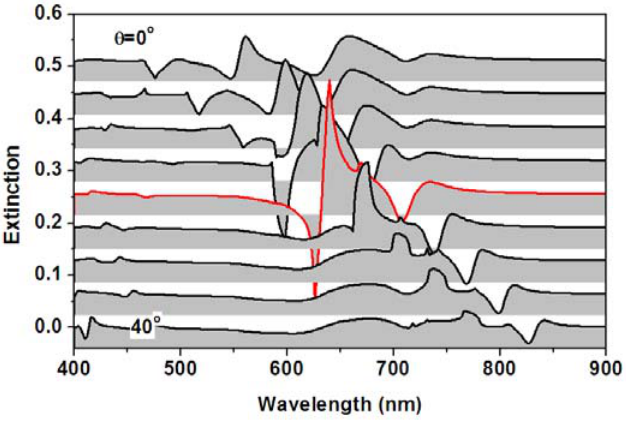
Figure 12. The extinction spectra at different angles of incidence (from 0 to 40 degrees in steps of 5 degrees) with the transmission spectra for n = 1.36 used as the signal and those for n = 1.33 as the